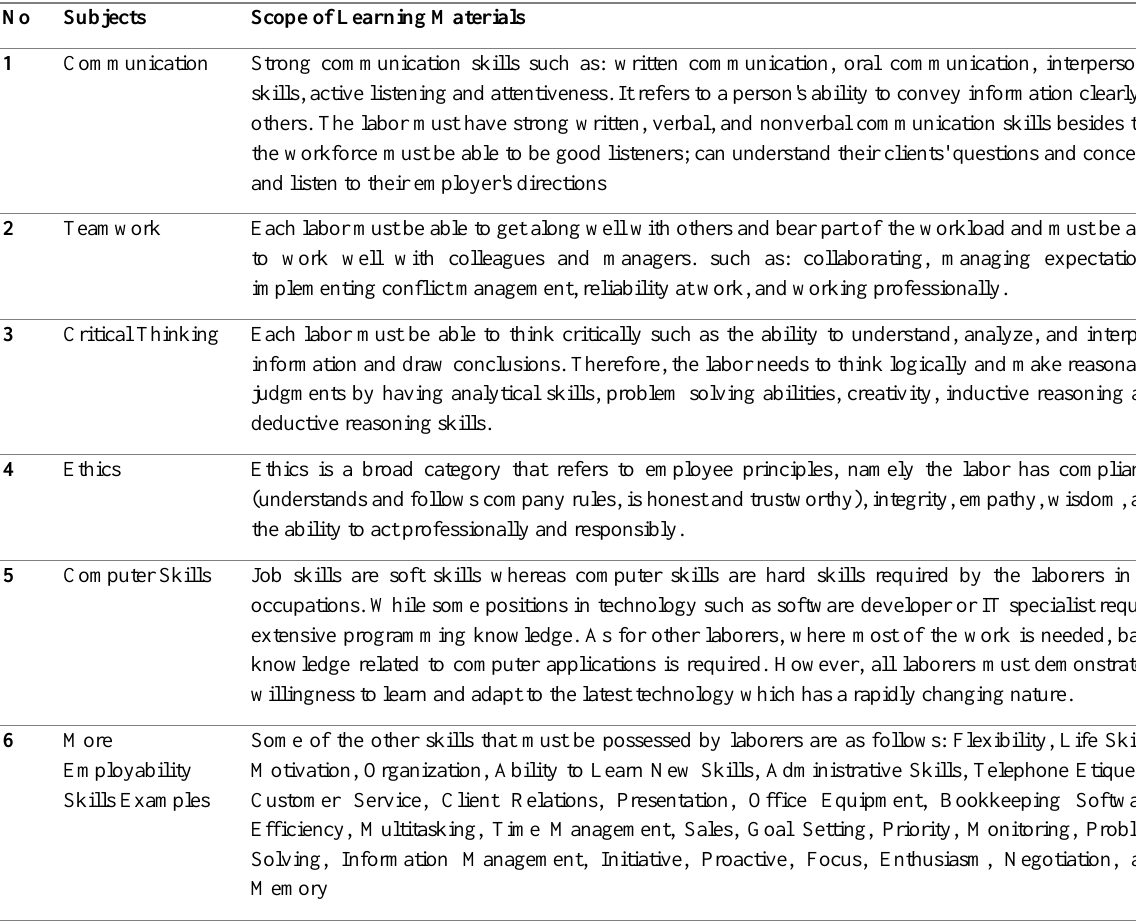
Table 1: Subjects and Scope of Learning